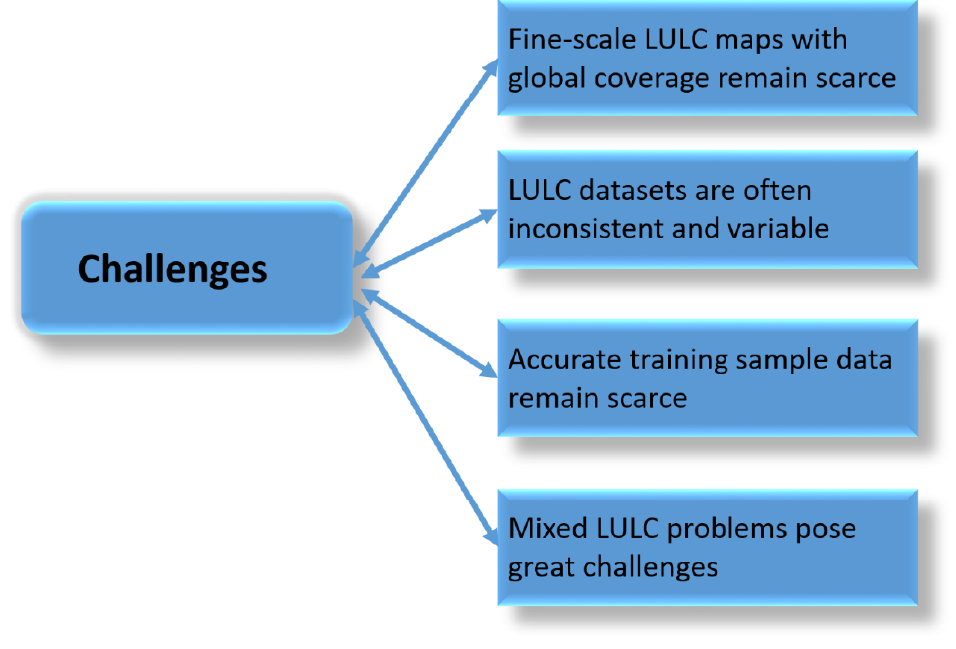
Figure 9. Major challenges of LULC mapping.